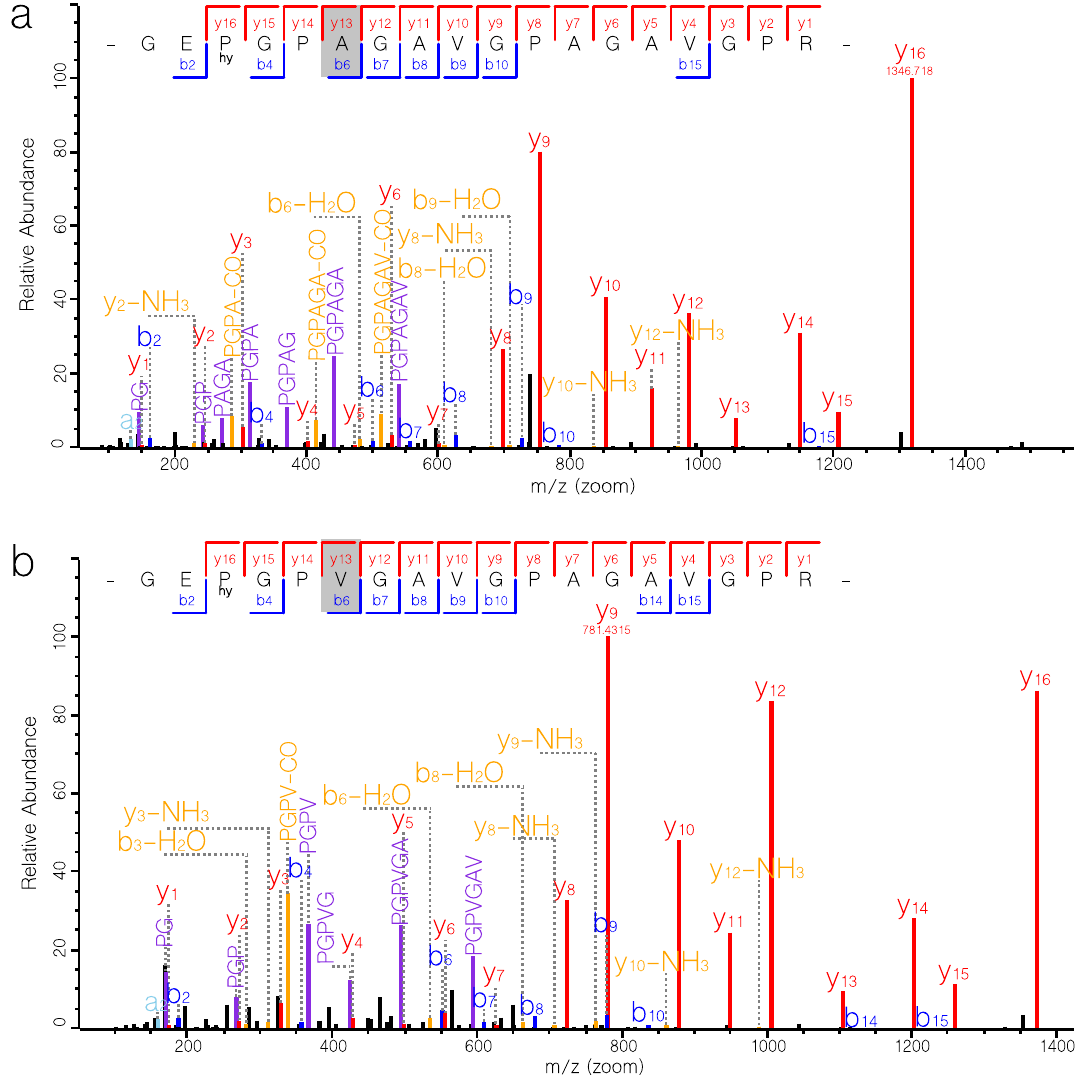
Figure 3. LC–MS/MS spectra from ( a ) modern reference springbok A and ( b ) modern reference sheep G. Grayed amino acids represent SAPs used to differentiate between the two